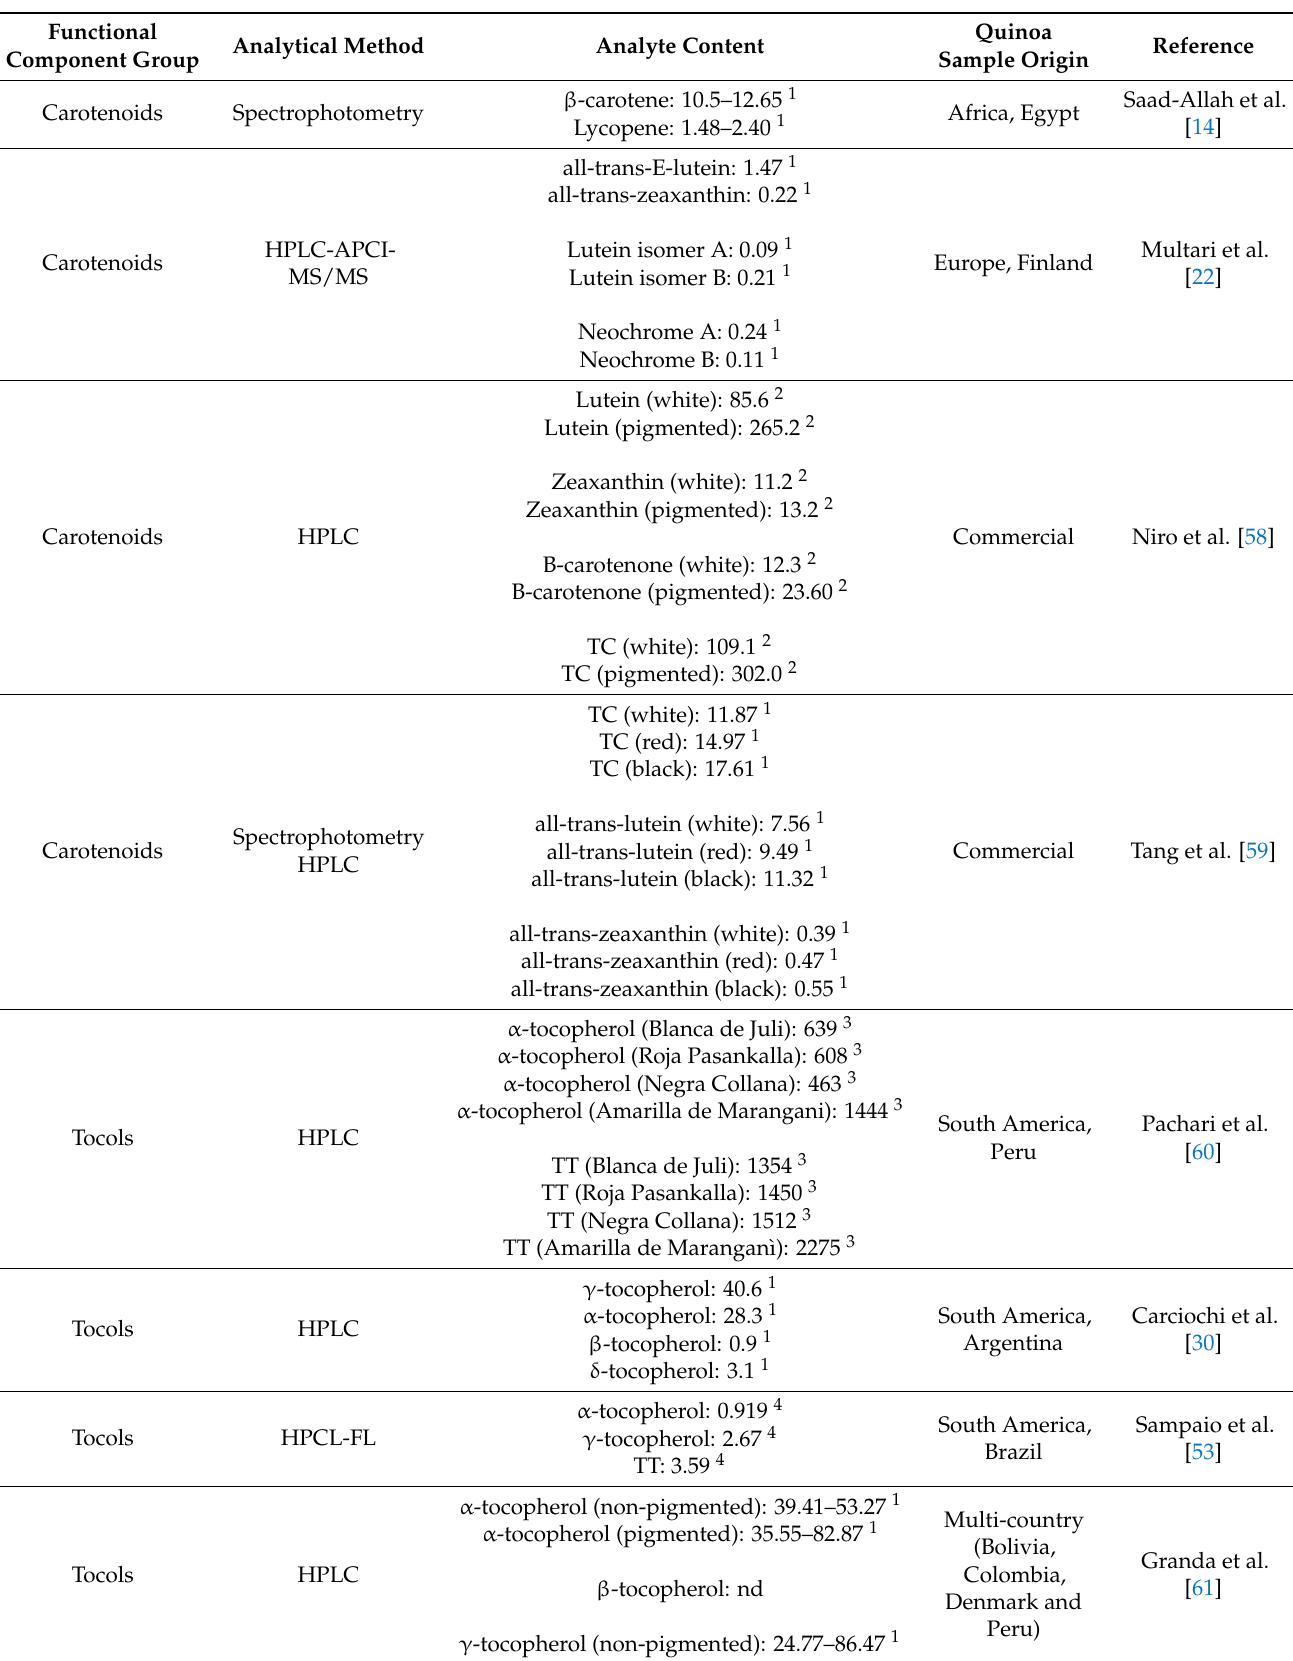
Table 5. Lipophilic non-nutrient functional components in quinoa